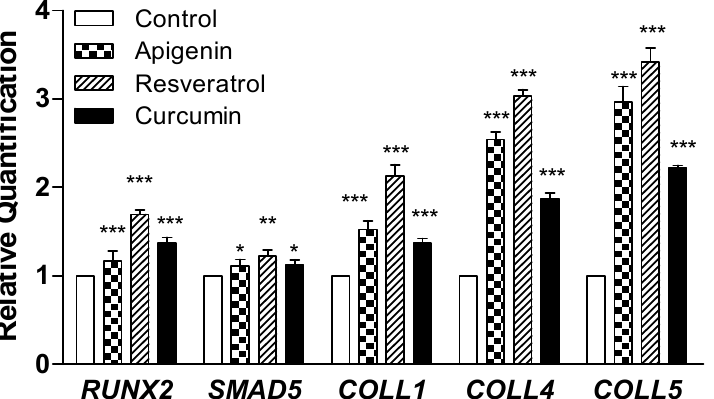
Figure 4. RT-PCR of RUNX2 , SMAD5 , COLL1 , COLL4 , and COLL5 . The graph shows the expression of analyzed genes after 14 days of differentiation in DM. Data derived from three different experiments (each n = 3) are reported as relative quantification means ± standard error. Unpaired t-test was applied to compare apigenin, resveratrol, curcumin, and the control group (* p < 0.05, ** p < 0.005. *** p < 0.0005).